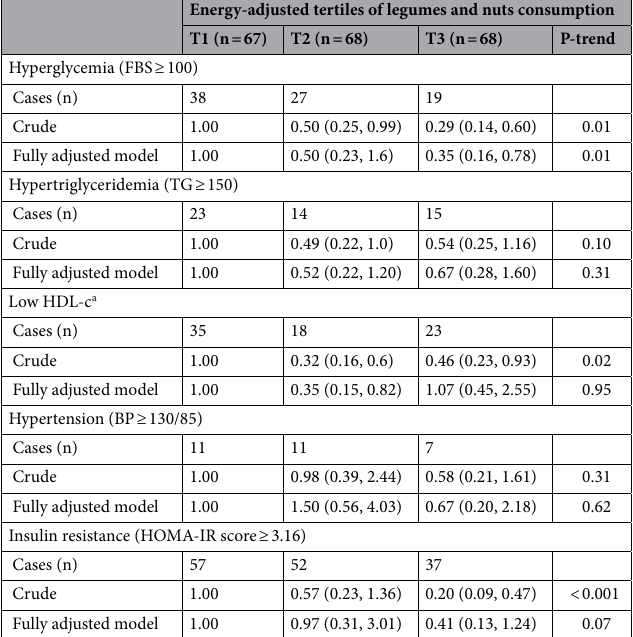
The relation between energy-adjusted legumes and nuts consumption with odds of MUO, stratified by BMI status of participants, are presented in Table 5. In overweight participants, although there was an inverse sig- nificant association between intakes of legumes and nuts and odds of MUO in the crude model, this association disappeared after adjustment for all confounders. In obese subjects, there was no significant association in crude or adjusted models, based on both definition criteria.